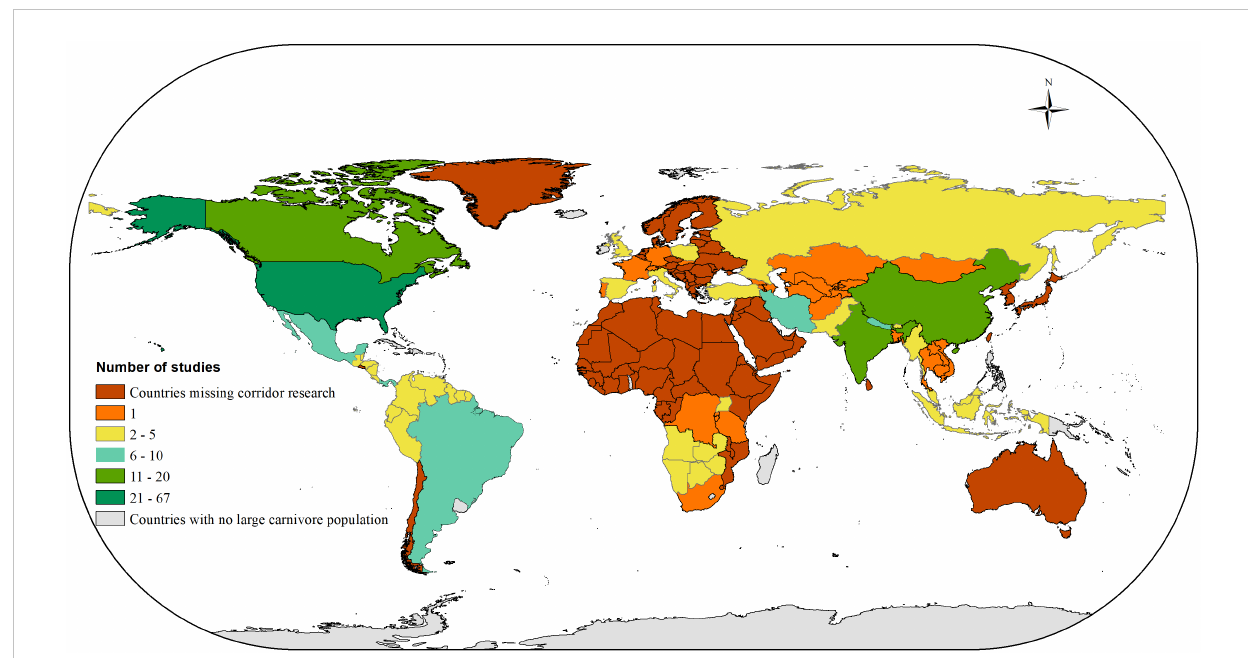
FIGURE 5 Geographical gaps in scienti fi c research on the identi fi cation and use of corridors for large carnivore conservation. The geographic distribution of large carnivore species used to identify these gaps is based on IUCN Red List data (IUCN, 2022). The cumulative number of studies conducted for all species across their geographic distribution is